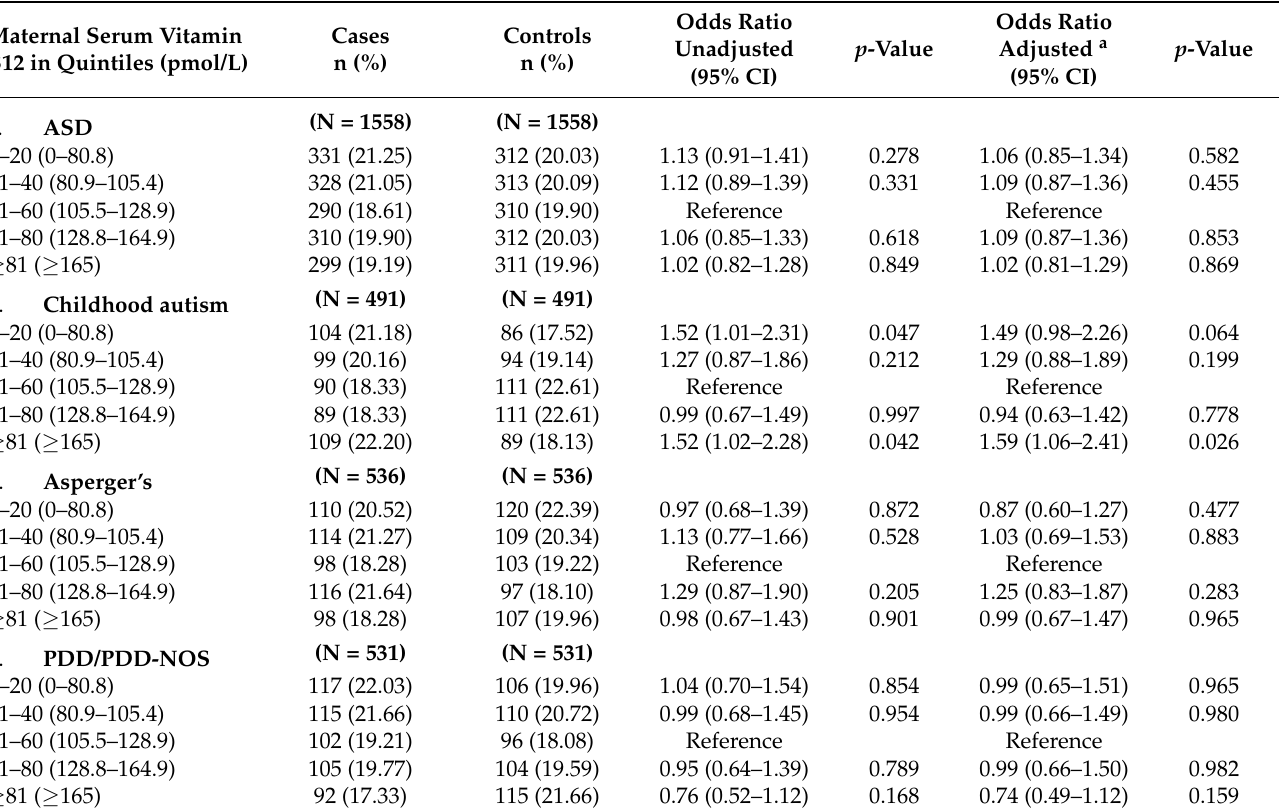
Table 4. Odds ratios and 95% CIs for the association between maternal serum vitamin B12 levels (in quintiles) and offspring ASD and subtypes.